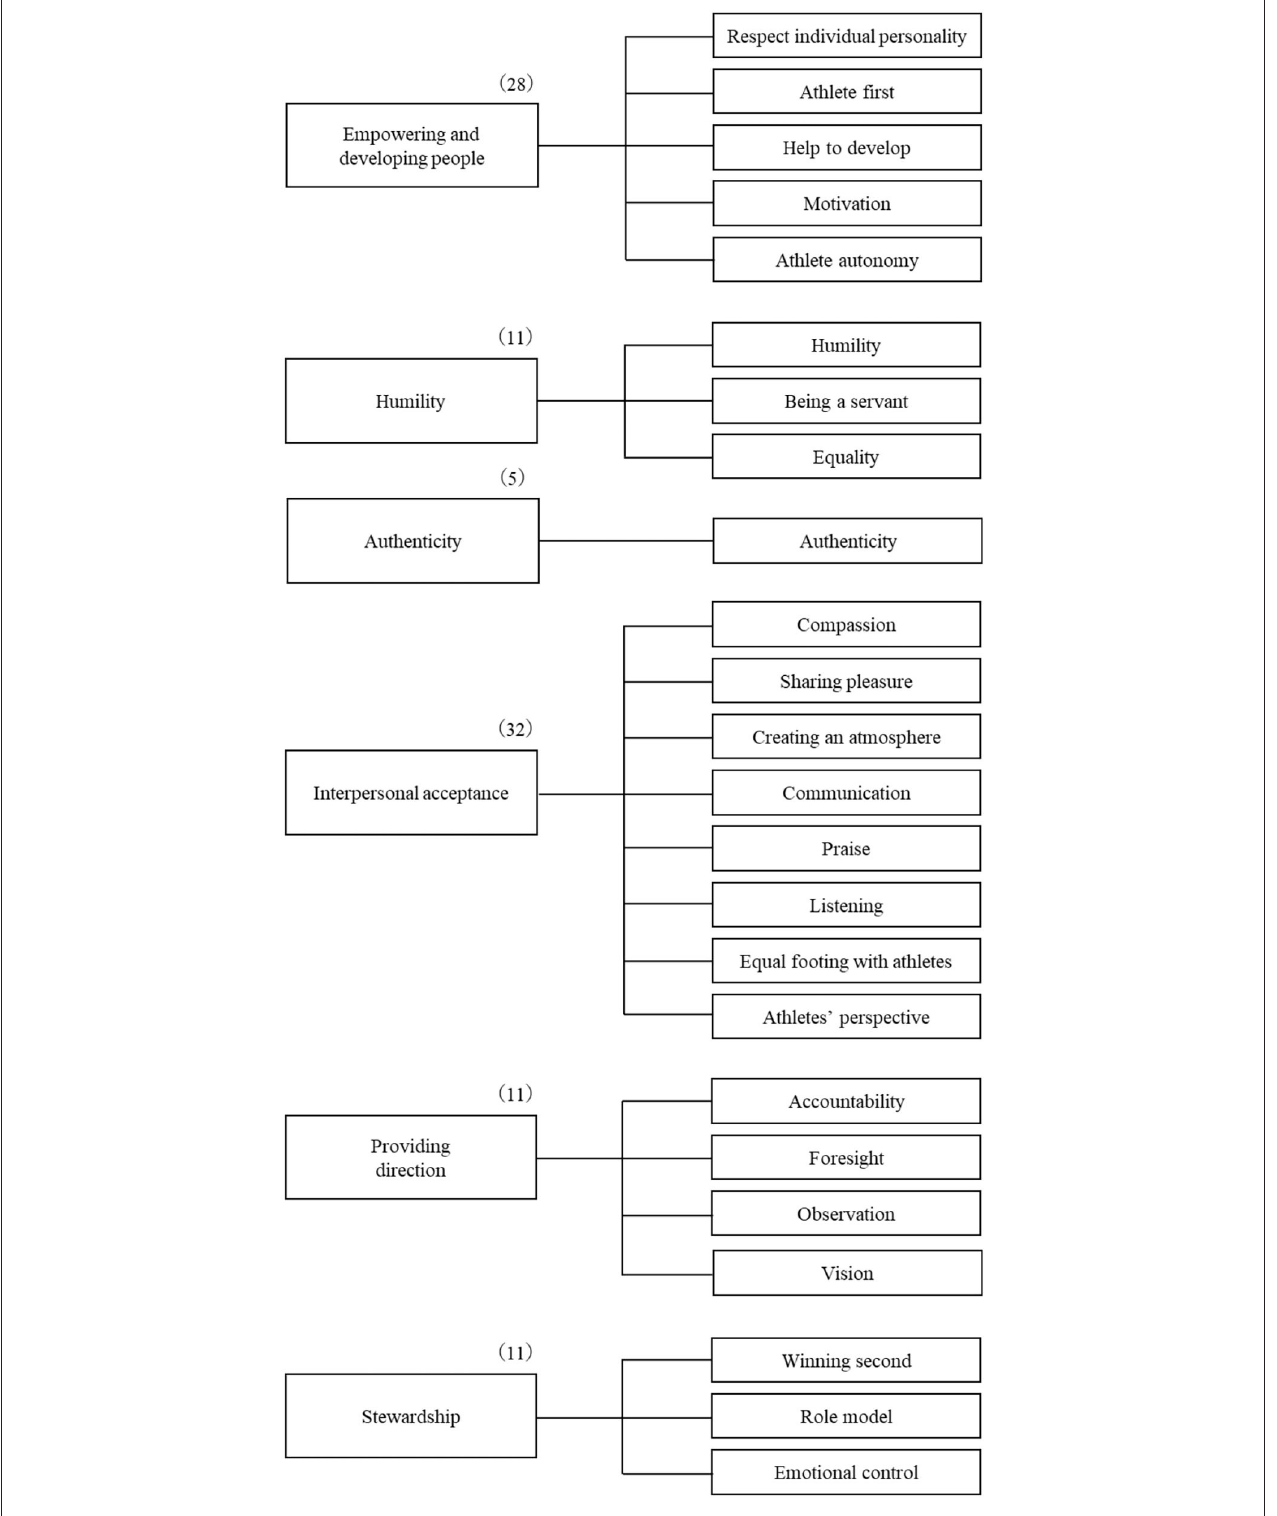
FIGURE 1 | Classification of qualitative data based on the six categories proposed by Van Dierendonck (2011). Each number in parentheses indicates the number of items collected.